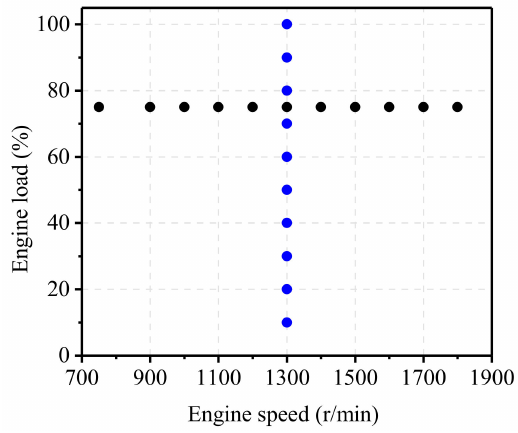
Figure 2. The tested operating